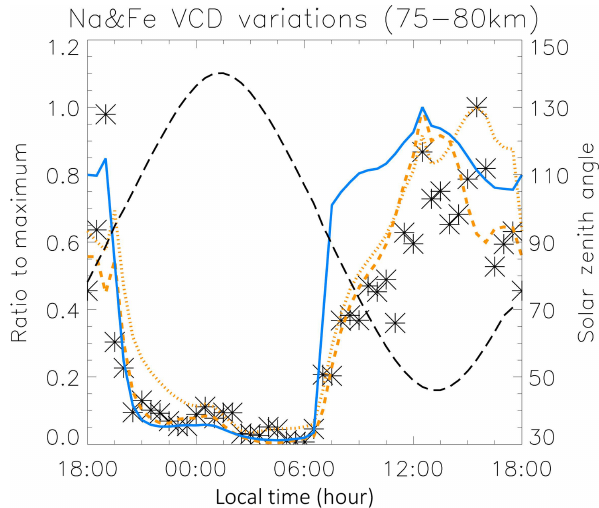
Figure 3. The variations in Na VCD (75–80km) measured the USU Na lidar during the 7-day Na lidar campaign (asterisks), simulated by WACCM_Na 88-level run (orange dotted line) and 144-level run (orange dashed line) and solar zenith angle (black long-dashed line), along with Fe VCD (75–80km), simulated by the WACCM_Fe 144- level run (blue solid